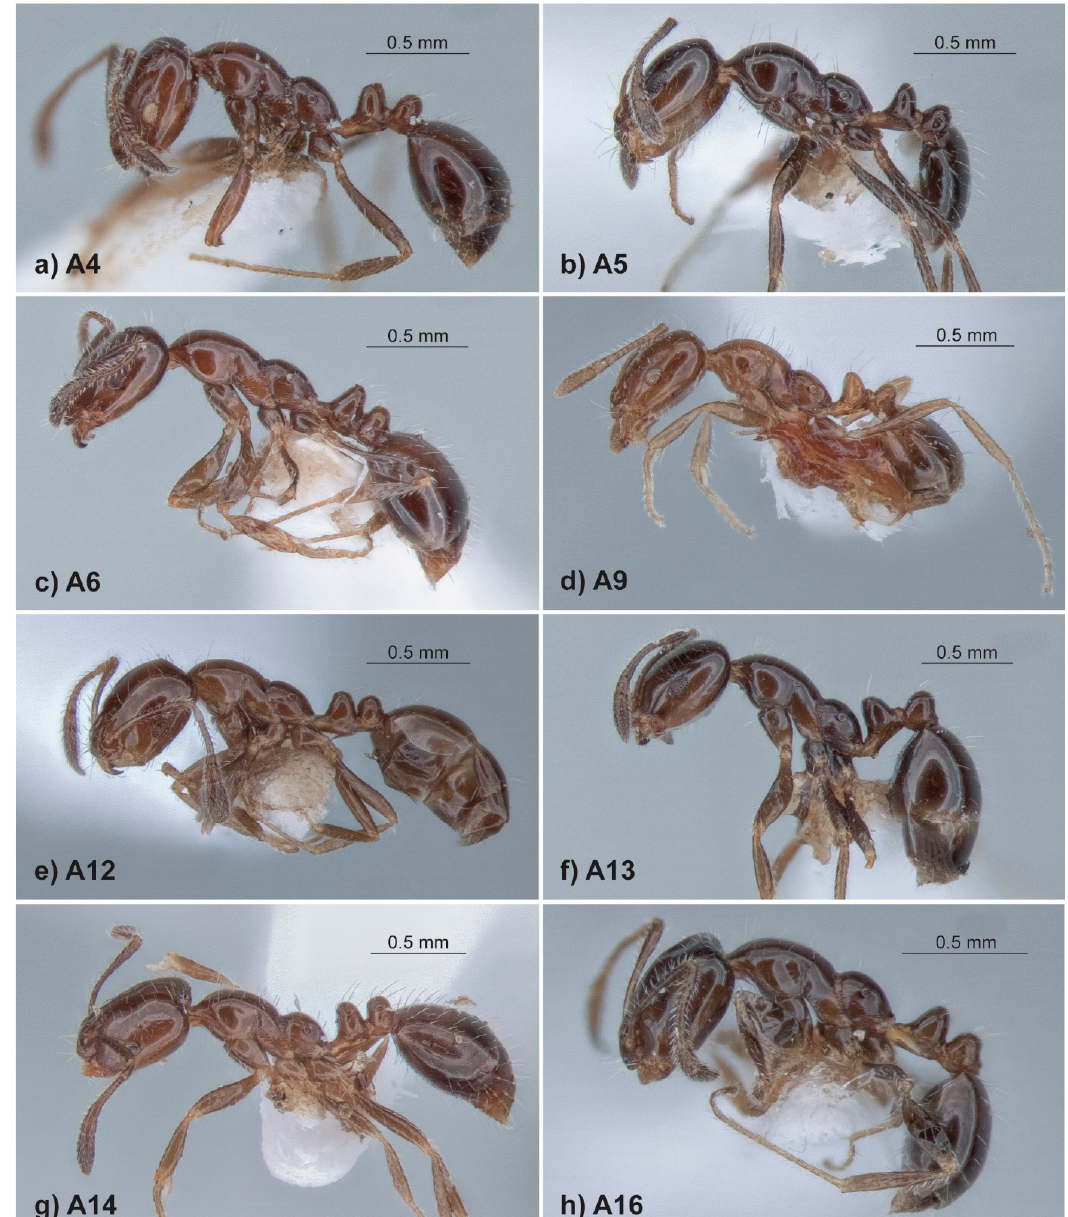
Figure 4. Images of species from the ‘ fieldi ’ morphotype. ( a ) Specimen MONO237-16; Kakadu NP, NT; ( b ) specimen OZBOL1366-21; Douglas Daly, NT; ( c ) specimen DARW347-15; Eurardy Stn, WA; ( d ) specimen MONS028-18; Nitmiluk NP, NT; ( e ) specimen OZBOL1364-21; Lakefield NP, Qld; ( f ) specimen OZBOL4008-21; Forrest Hill Stn., NT; ( g ) specimen MONO254-16; Lizard Island, Qld; ( h ) specimen OZBOL4004-21; Hayfield Shenandoah Stn, NT.